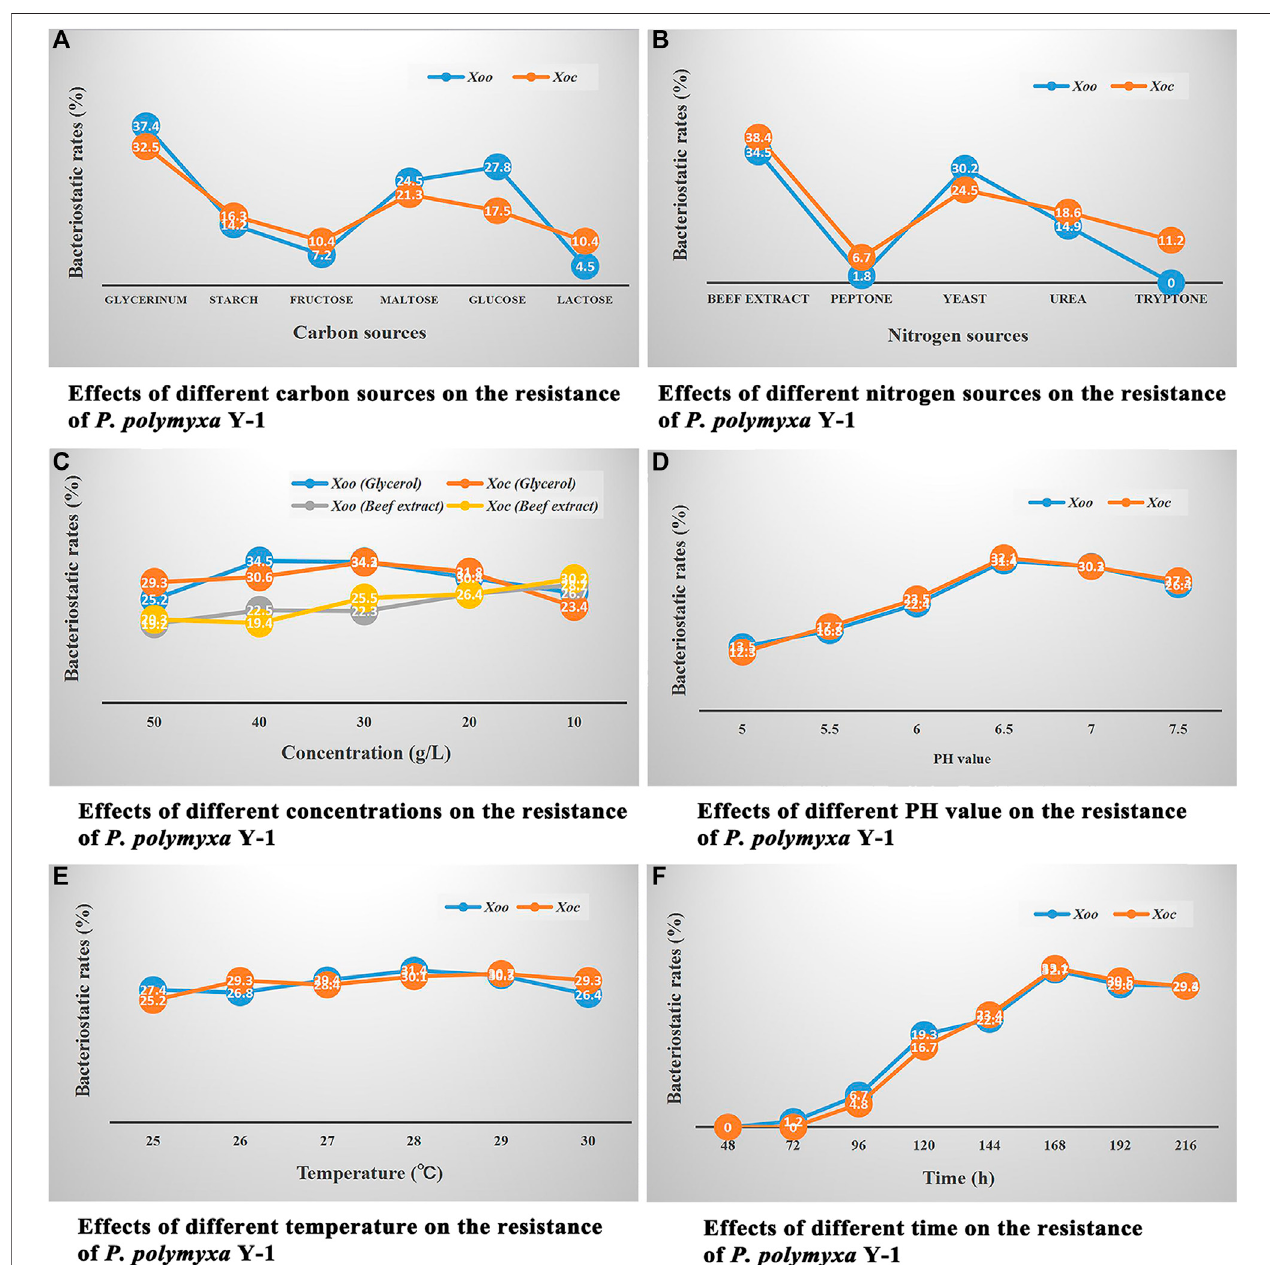
FIGURE2| Singlefactorexperimentassay. (A) Effectsofdifferentcarbonsourcesontheresistanceof P.polymyxa Y-1. (B) Effectsofdifferentnitrogensourceson theresistanceof P.polymyxa Y-1. (C) Effectsofdifferentconcentrationsontheresistanceof P.polymyxa Y-1. (D) EffectsofdifferentpHontheresistanceof P.polymyxa Y-1. (E) Effects of different temperature on the resistance of P. polymyxa Y-1. (F) Effects of different time on the resistance of P. polymyxa Y-1.